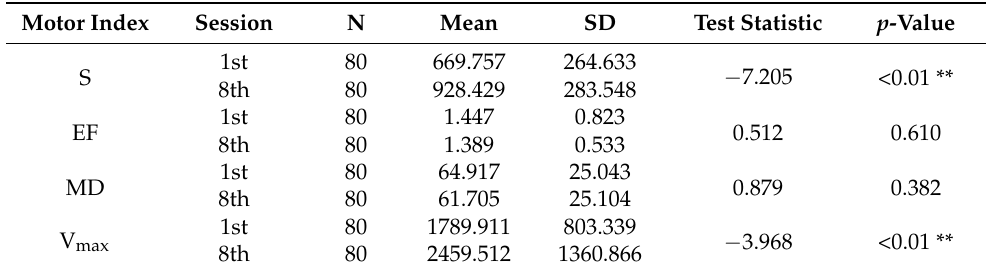
Table 9. Summary statistics and paired t -test for comparing motor indecies in Mode 2 between the first and eighth training for the Barman VR task.